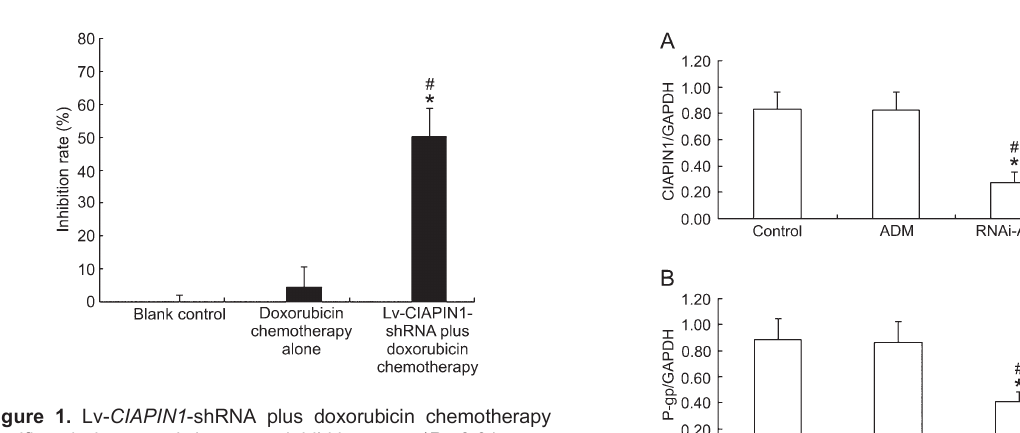
Figure 1. Lv- CIAPIN1 -shRNA plus doxorubicin chemotherapy significantly increased the tumor inhibition rate. *P , 0.01 com- pared with doxorubicin chemotherapy group; # P , 0.01 compared with blank control ( t -test).